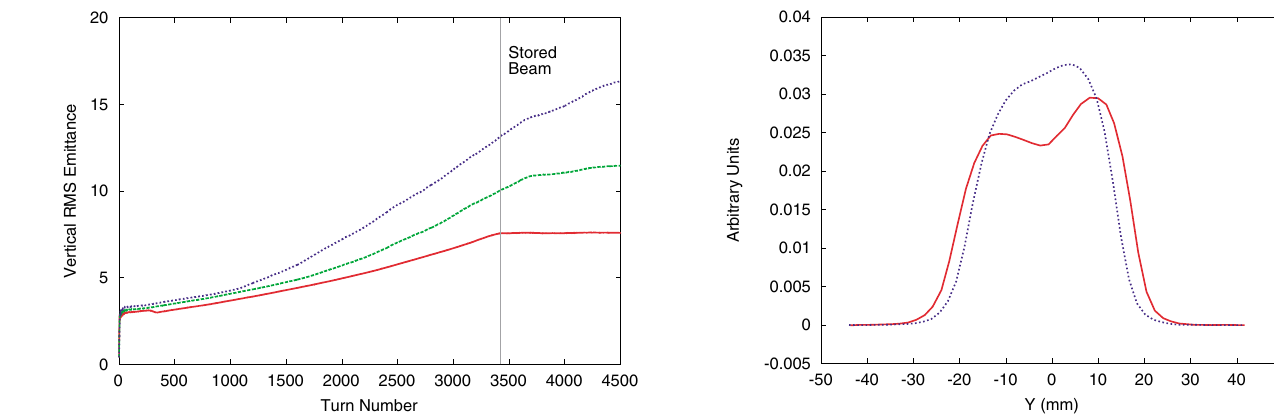
FIG. 22. (Color) Experimentally measured vertical beam pro- files for two different painting schemes of a low intensity beam. (cid:5) The red curve is the beam with a 17.51 mm injection offset, and y (cid:5) 2 : 13 , and the blue curve is the beam with a 12.61 mm injection offset. y (cid:5) 2 : 09 . The dashed y